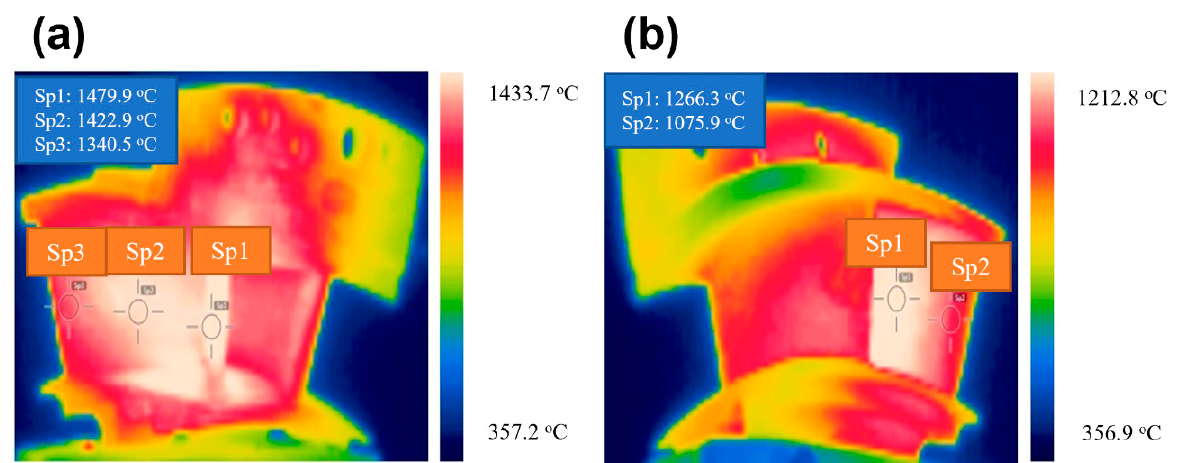
Figure 7. Surface temperature distribution for the twin guide vanes under thermal shock test at the target temperature of T = 1480 °C ( a ) Basin area of the left guide vane; and ( b ) Back area of the right guide vane.